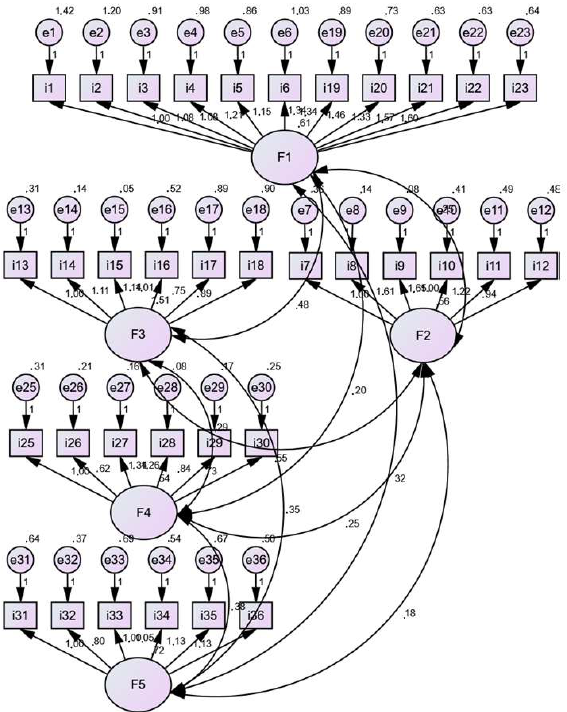
Figure 1. Confirmatory factor analysis for the questionnaire “COVID-19 Stress